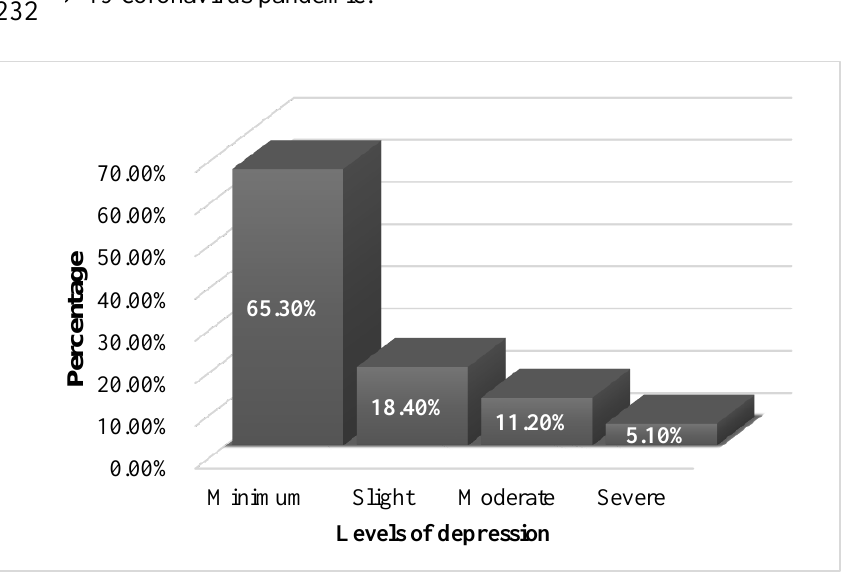
Figure 1. Level of depression of university students in